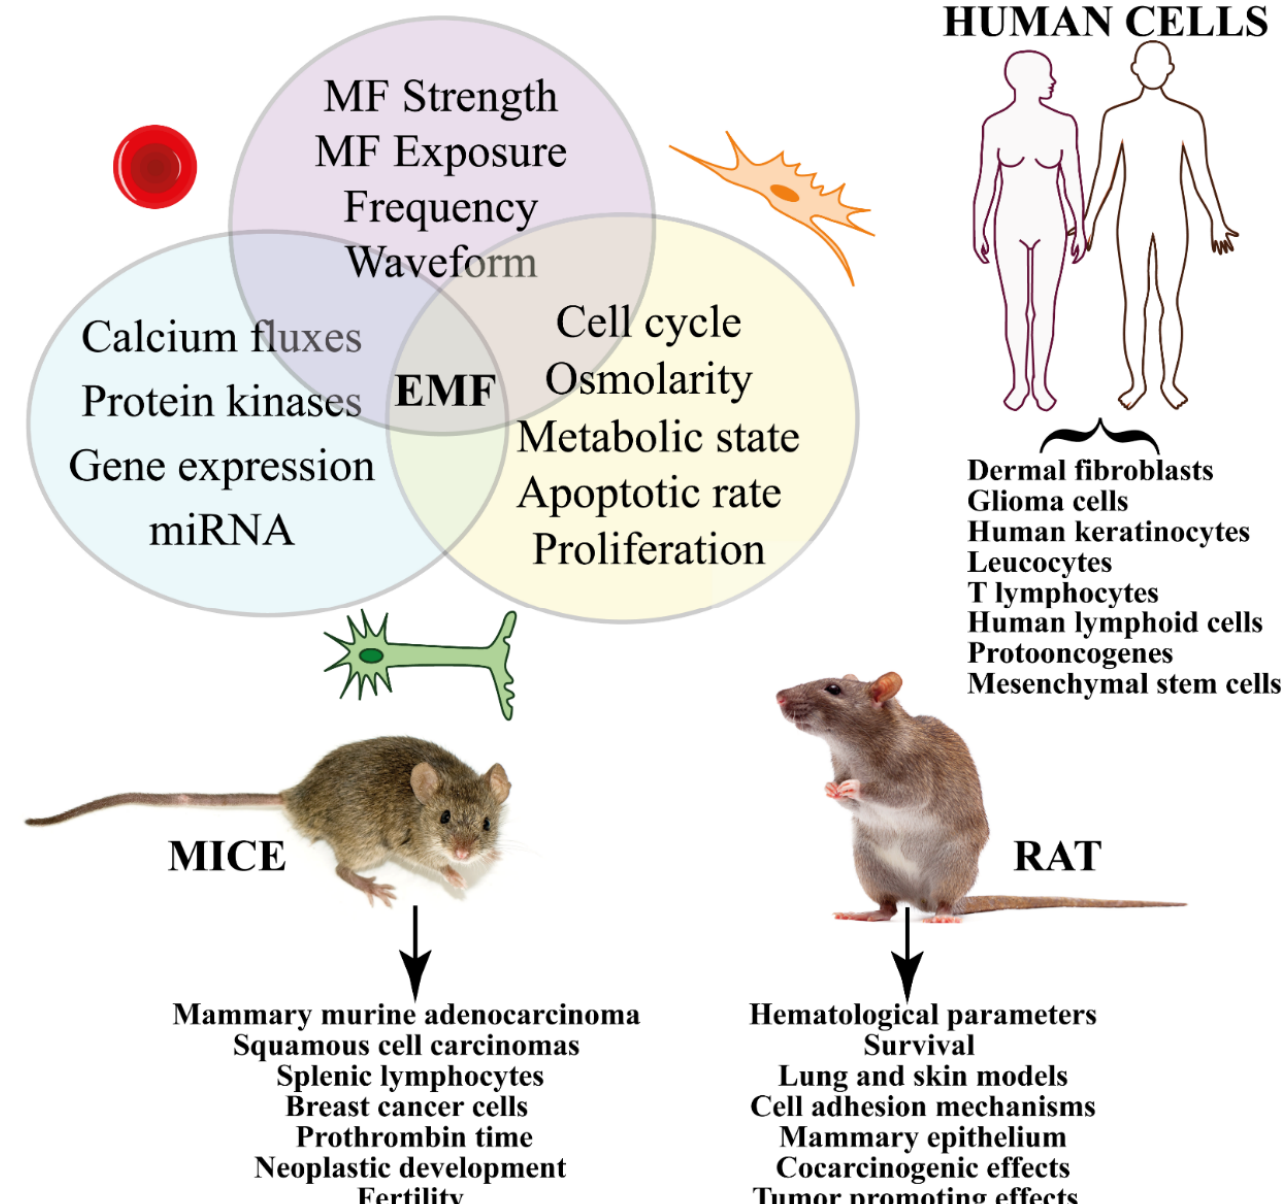
Figure 4. Summary of the in vivo and in vitro effects of MFs on cancer from studies on human and animal cells. Different treatments (e.g., strength, duration, frequency, etc.) induce signal transduction pathways that eventually trigger gene expression. In vitro studies show significant effects on cell cycle, proliferation, and apoptosis. Human cells have been used to evaluate the effect of MF on several cancer types, whereas animal experimentation has been focused on mice and rats.